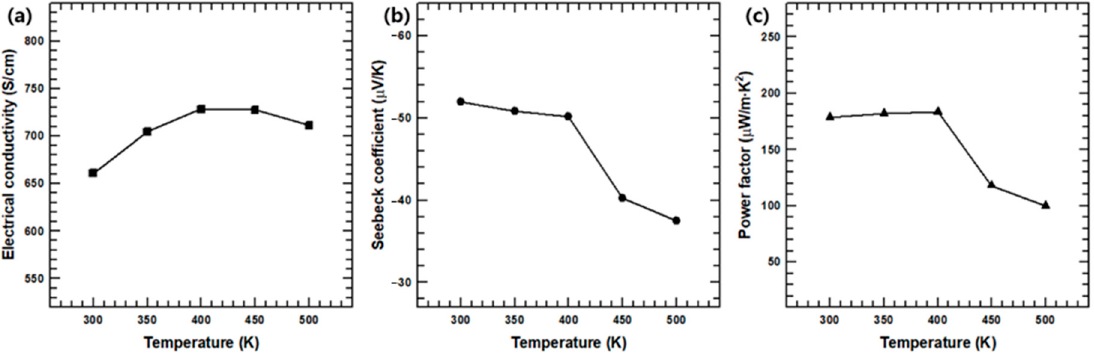
Figure 7. ( a ) Electrical conductivity, ( b ) Seebeck coefficient, and ( c ) power factor values of Ag 2 Se NW/PEDOT:PSS composite films with 80 wt.% of Ag 2 Se as a function of temperature.